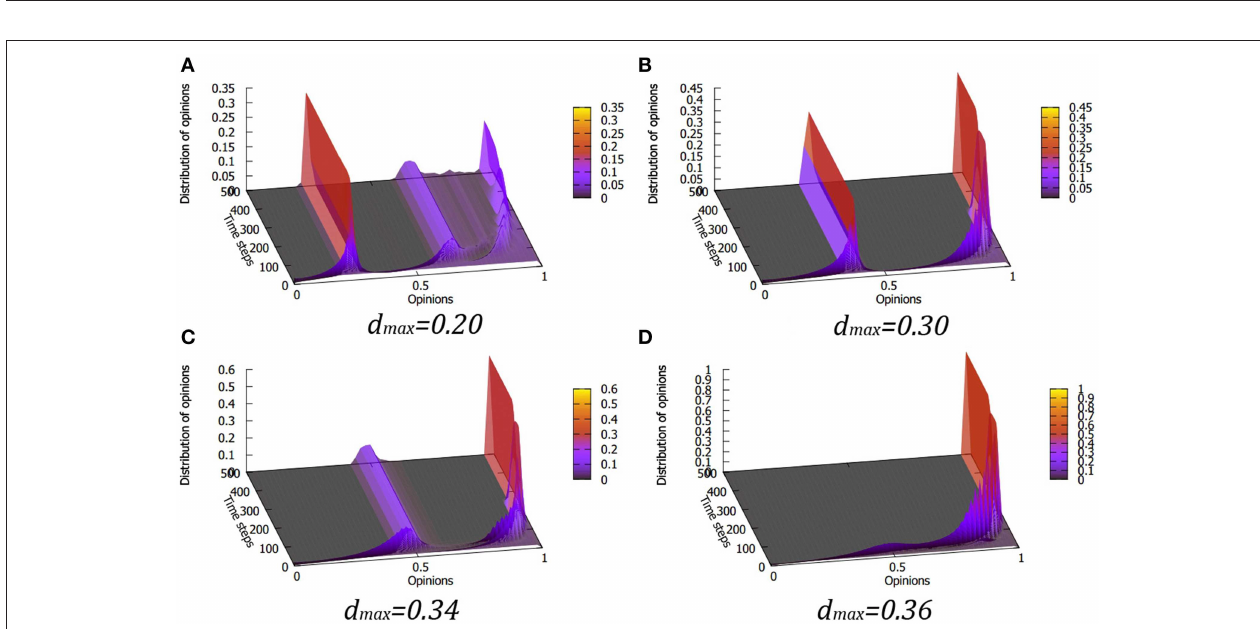
FIGURE 4 | Evolution of opinion distributions for various values of the maximum tolerance d max for L = 3 . The results are very similar to the case of L = 2 . Panels (A–D) correspond to d max values of 0.20, 0.30, 0.34 and 0.36,